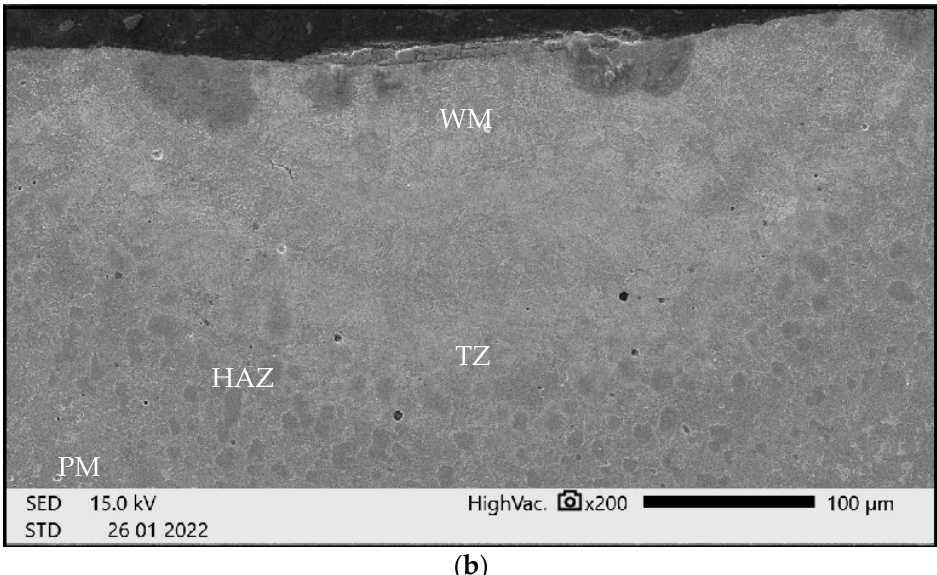
Figure 21. Sample no 1 reached with 50 Hz acoustic vibration delivered transversely: ( a ) Metallog- raphy and ( b ) SEM; PM—parent metal, HAZ—heat affected zone, TZ—transition zone, WM—weld metal.